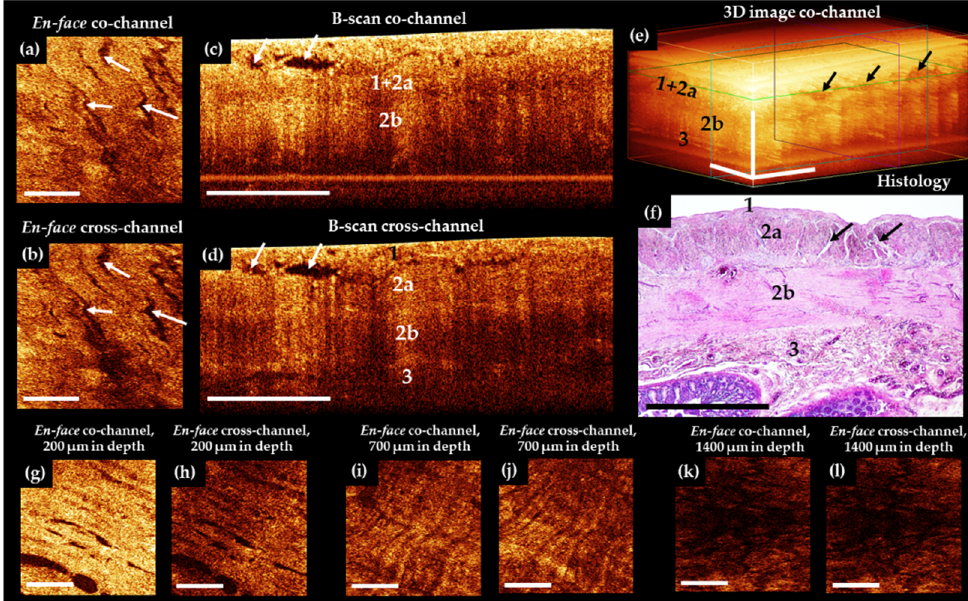
Figure 3. Representative trans-serosal CP OCT images of normal human ileum. In the B-scan cross- channel ( d ) the serous membrane (1), muscularis externa (longitudinal muscular layer 2a and circular muscular layer 2b) and the boundary with submucosa (3) are more clearly resolved, while in the co-channel, not all anatomical layers are optically separated ( c , e ). ( a , b ) En-face OCT images at the level of the longitudinal muscular layer (green horizontal line in ( e )). Intermuscular spaces (( f ), black arrows) look like slits in CP OCT images (( a – d ), white arrows; ( e ), black arrows) and they are located within the outer muscular layer. ( f ) Corresponding histological image, H&E staining. In some cases, a clear change in the direction of muscle bundles in different layers ( g – j ) and a characteristic pattern of the lamina propria ( k , l ) immediately under the muscularis mucosa can be observed. Scale bars 1 mm.